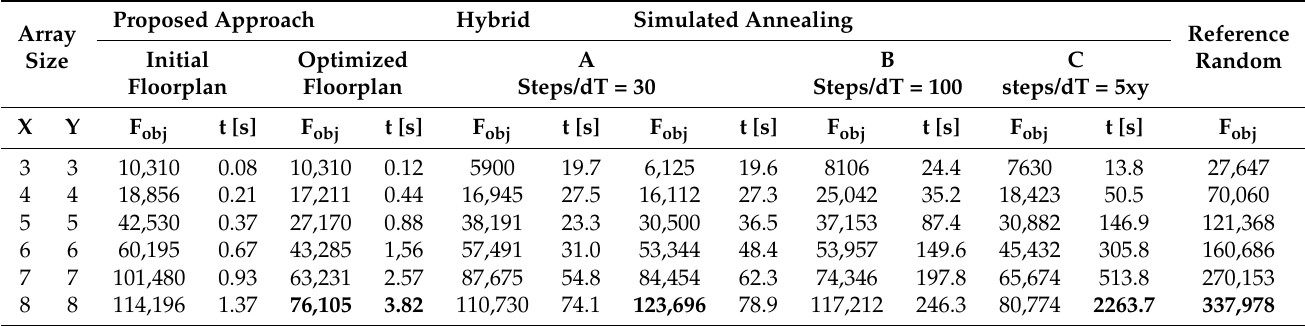
Table 2. Comparison of floorplanning methods for